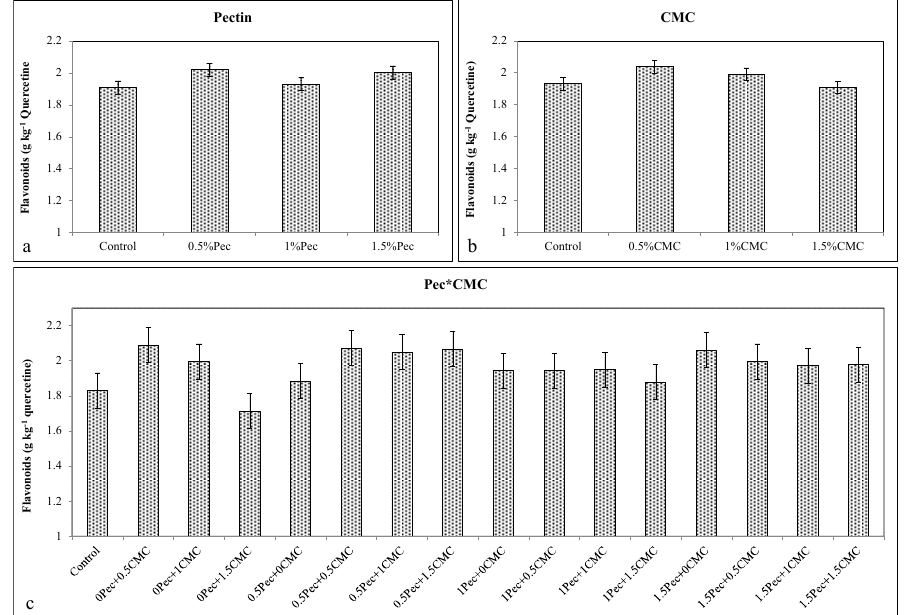
Figure 8. Effect of 0 (control), 0.5 (0.5% Pec), 1 (1% Pec) and 1.5 (1.5% Pec) % pectin-based edible coatings ( a ), 0 (control), 0.5 (0.5% CMC), 1 (1% CMC) and 1.5 (1.5% CMC) % carboxymethylcellulose- based edible coatings ( b ) and their combinations ( c ) on flavonoids contents during cold storage period. Data are the “estimated marginal means ±95% confidence intervals”. The results were expressed on a fresh weight basis. The columns with non-overlapping error bars are significantly different ( p ≤ 0.05).